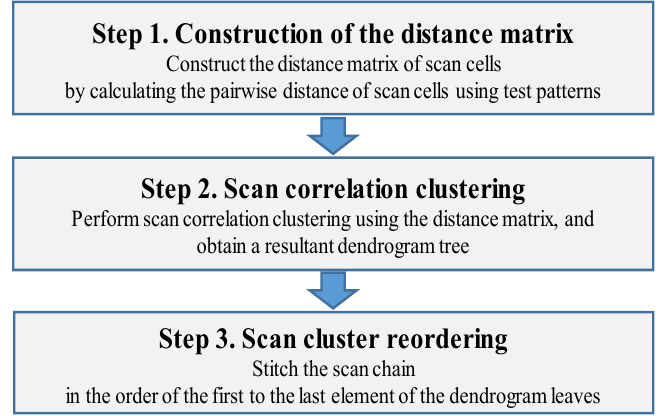
Figure 4. Overall flow of the proposed method.